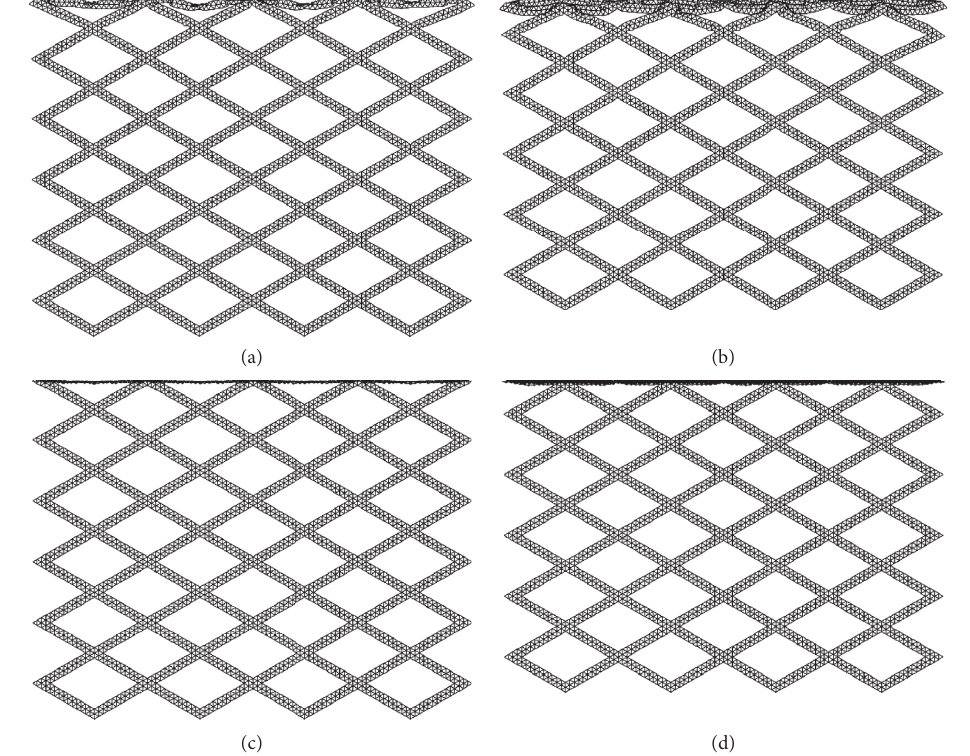
Figure 13: FE prediction of the dynamic collapse of the DHH in the x direction, ρ � 5% and N � 12. (a) V � 50m/s, ε � 10%. (b) V � 50m/s, ε � 17%. (c) V � 200m/s, ε � 10%. (d) V � 200m/s, ε �